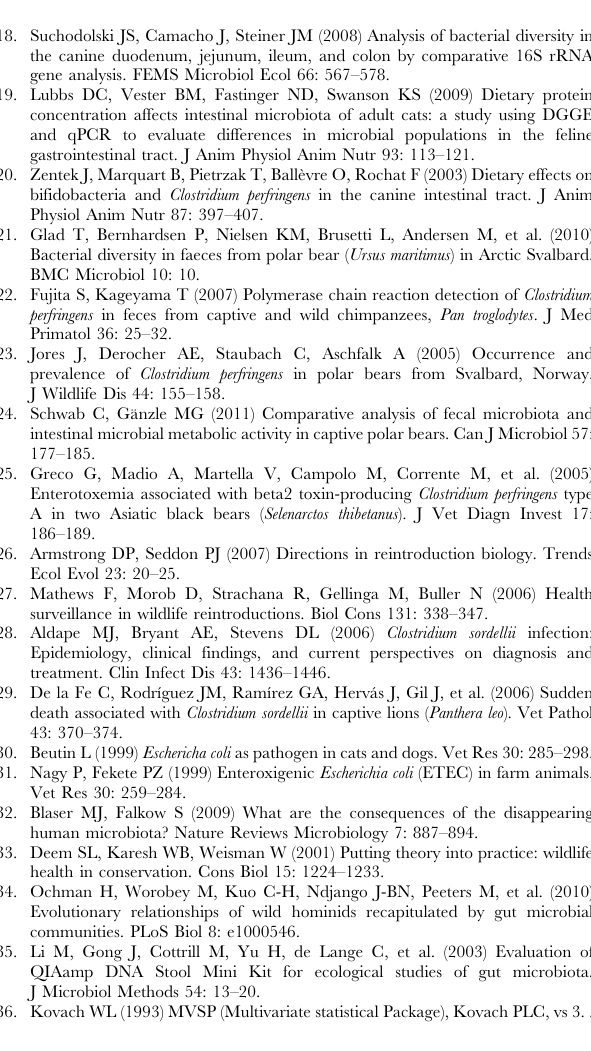
Figure S1 Wild grizzly bear diet content. Diet content in the feces of a bears W1 (A) and W2 (B) of population 1, and of bears W5 (C) and W6 (D) of population 2. Diet content was categorized as plant material (plant), mammalian matter (mam- mal), insect and miscellaneous (misc). Table S1 Bacterial populations [log DNA gene copy numbers g 2 1 feces] in the feces of wild and captive grizzly bears. Average values were calculated from samples of individual bears and were analysed using one-way ANOVA. Table S2 Selected bacterial groups present in the feces of three adult wild grizzly bears and a grizzly bear cub at bear capture. Samples were analyzed as a control to identify the range of bacterial populations in wild grizzly bear feces. Bear W5